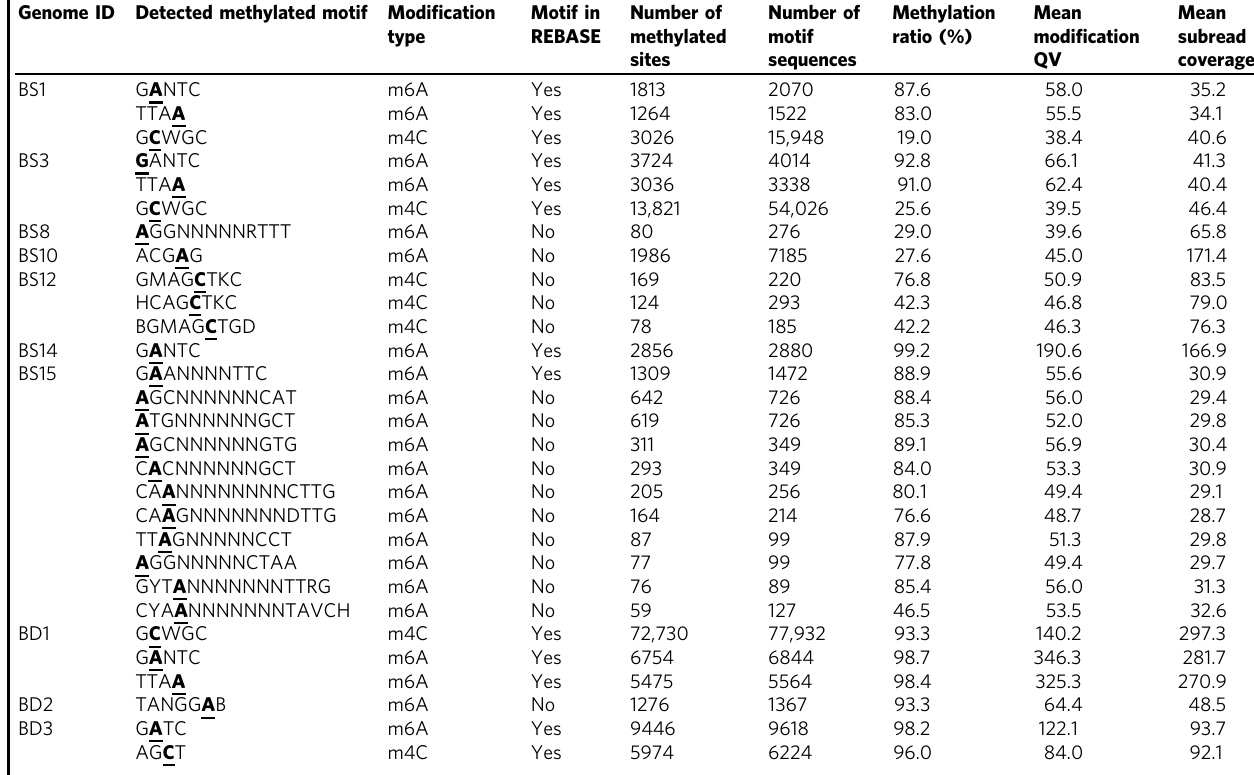
Table 3 Detected methylated motifs Genome ID Detected methylated motif Modi fi cation